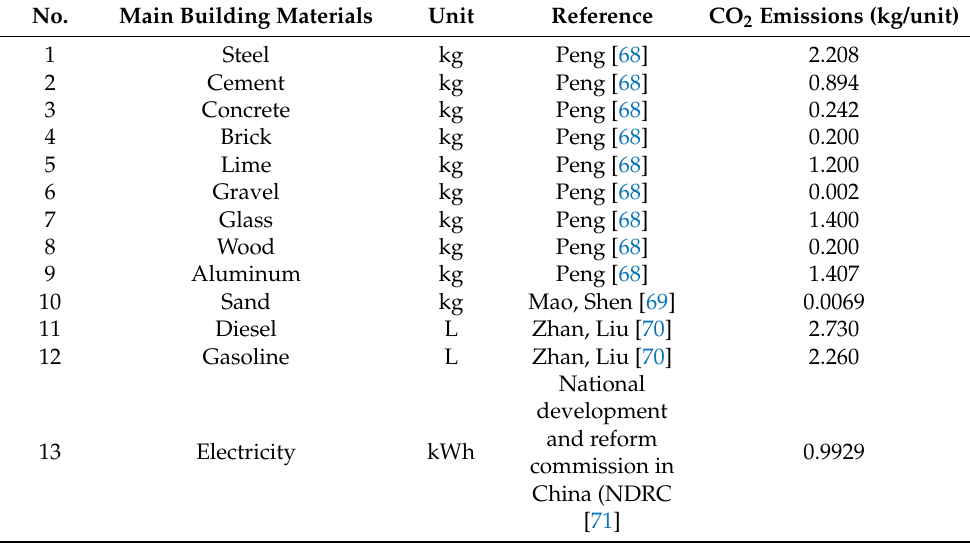
Table 2. Emission factors of the different